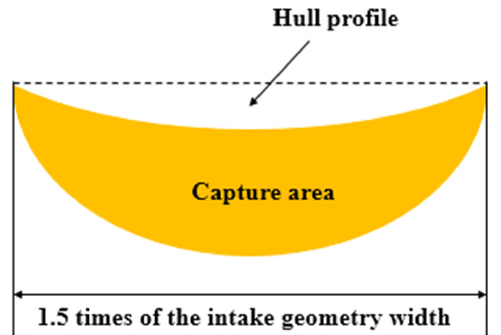
Figure 22. The sketch of the capture area.